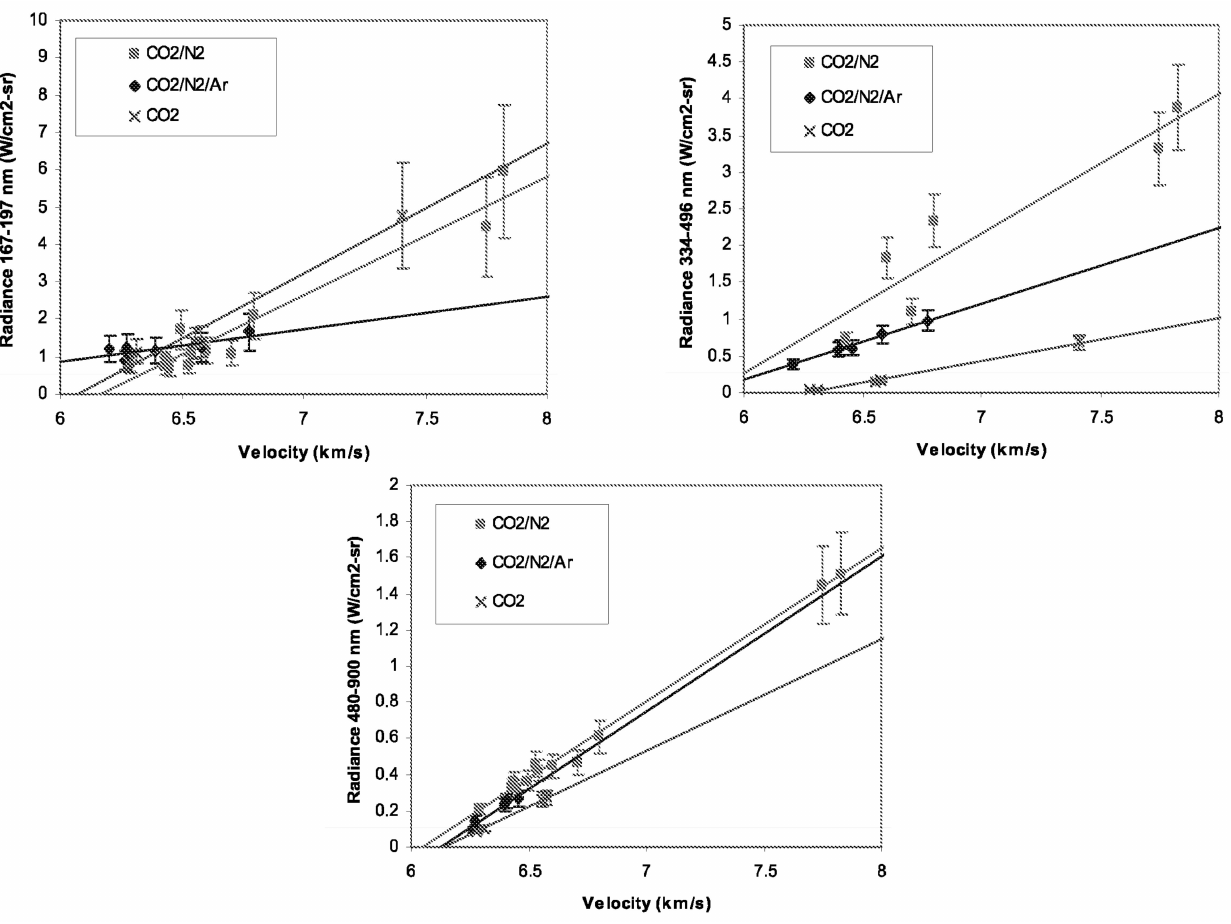
Figure 27. Steady state radiation for three Mars mixtures (pure CO 2 , 96:4 CO2/N2, and 95.7:2.7:1.6 CO 2 /N 2 /Ar) at 0.25 Torr: Top left: 167–197 nm, Top right: 334–496 nm, Bottom: 480–900 nm (from